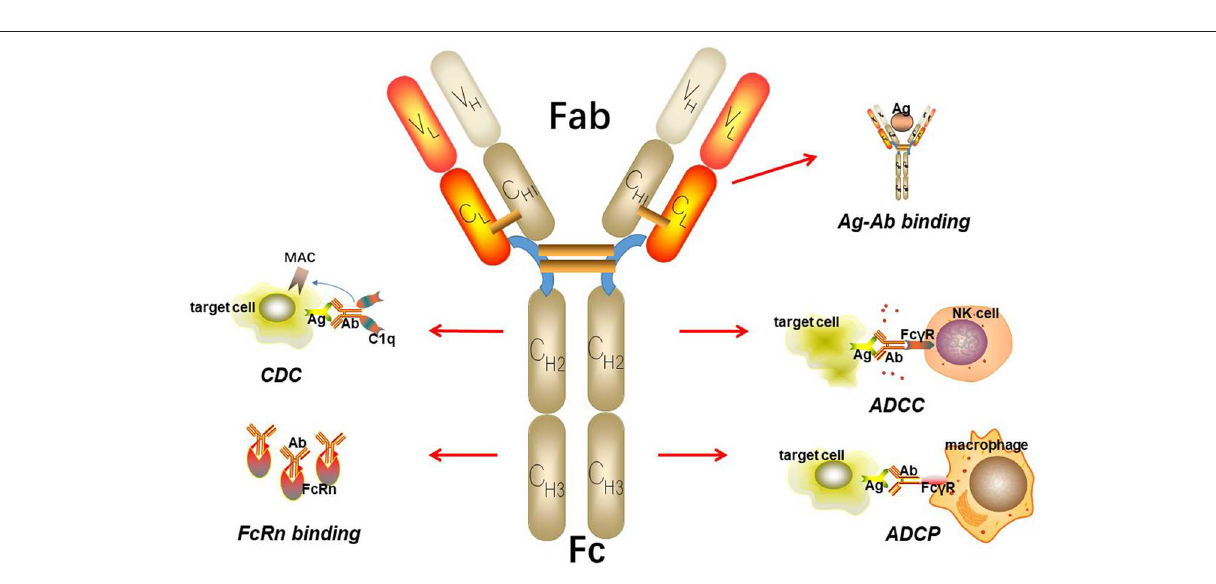
“inter-chain” disulfide bonds, as well as attenuated non-covalent interactions between the heavy chains in the CH3 region, thus resulting in the dissociation and recombination of heavy chains and further generating newly bi-specific heterozygous IgG4 with reduced avidity to antigen (28–30). Therefore, the core hinge Ser228Pro (S228P) mutation is a significant design consideration for therapeutic IgG4 antibodies to abrogate FAE (31,